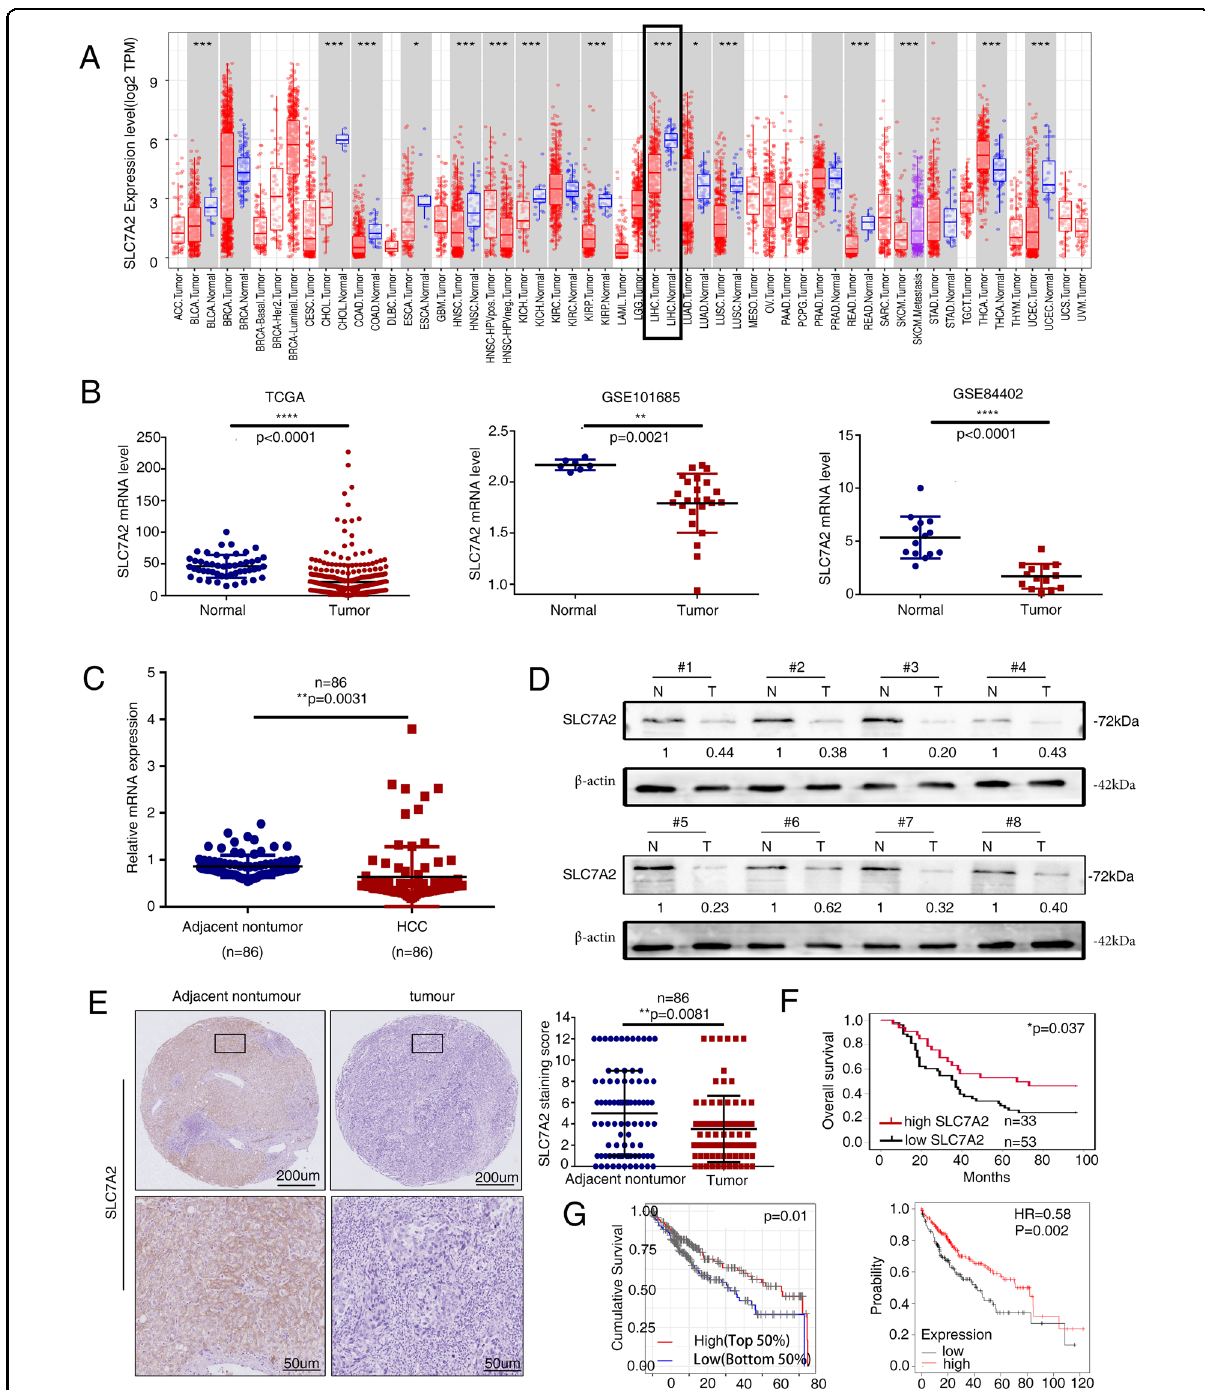
Fig. 1 SLC7A2 is signi fi cantly downregulated in HCC tissues and de fi cient SLC7A2 indicates a poor prognosis. A Expression of SLC7A2 in diverse cancer types from the TIMER website. B Bioinformatics analysis of SLC7A2 mRNA expression on the TCGA and the GEO database. (TCGA, GSE101685, GSE84402 contains 50, 7, 14 normal tissues and 374, 24, 14 HCC tissues, respectively). C Relative SLC7A2 mRNA expression in 86 paired HCC and adjacent nontumorous tissues. D Western blot analysis of SLC7A2 expression in eight pairs of human HCC samples and paired adjacent nontumor tissues. E Representative image of the IHC staining for SLC7A2. IHC scores of SLC7A2 in the HCC cohort. Scale bars, 200 µm (upper), 50 µm (lower). F Kaplan – Meier analysis of the association of SLC7A2 expression and overall survival in the HCC cohort. G Kaplan – Meier analysis of overall survival was compared according to the expression levels of SLC7A2 in HCC tissues from the TIMER and Kaplan – Meier Plotter website. All the data were shown as the mean ± s.d. * P < 0.05, ** P < 0.01, *** P < 0.001, **** P <